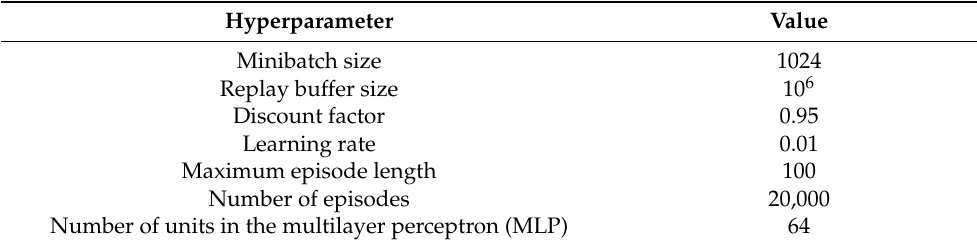
Table 1. The summary of the main hyperparameters and their